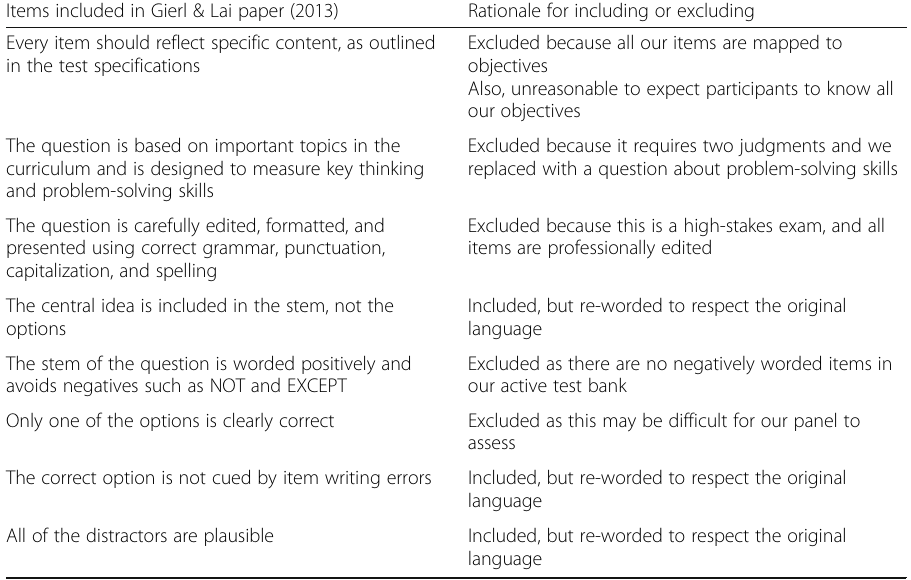
Table 2 Rationale for choice of quality metrics Items included in Gierl & Lai paper